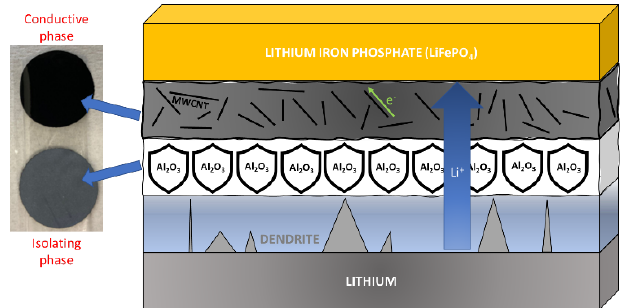
Figure 5. Naïve picture of the overall JM functionality.